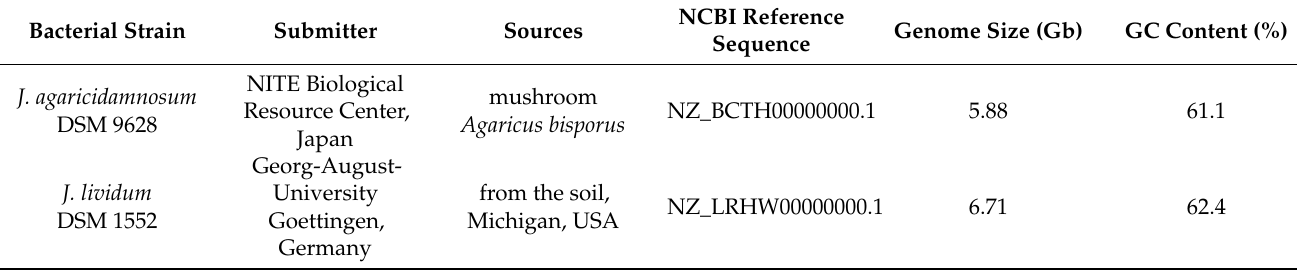
Table 2. General genomic features of the Janthinobacterium strain used in this study. Bacterial